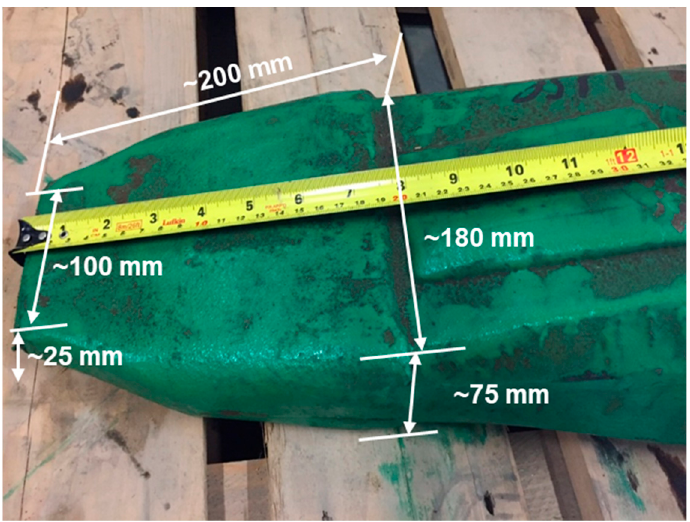
Figure 1. Photo and approximate dimensions of the tip portion of a shovel tooth used in Canadian oil sands mining.